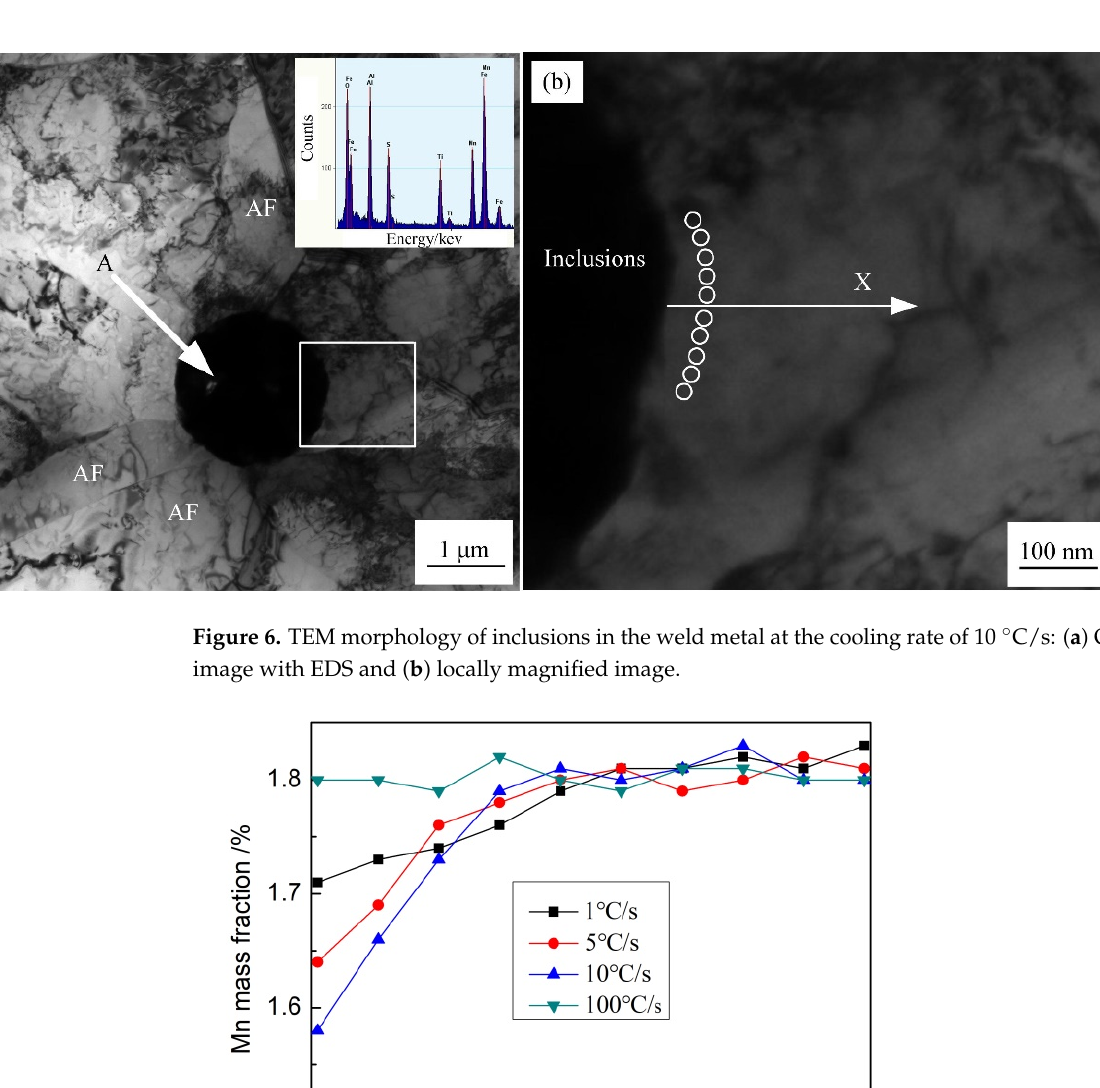
Figure 6. TEM morphology of inclusions in the weld metal at the cooling rate of 10 °C/s: ( a ) Original image with EDS and ( b ) locally magnified image.